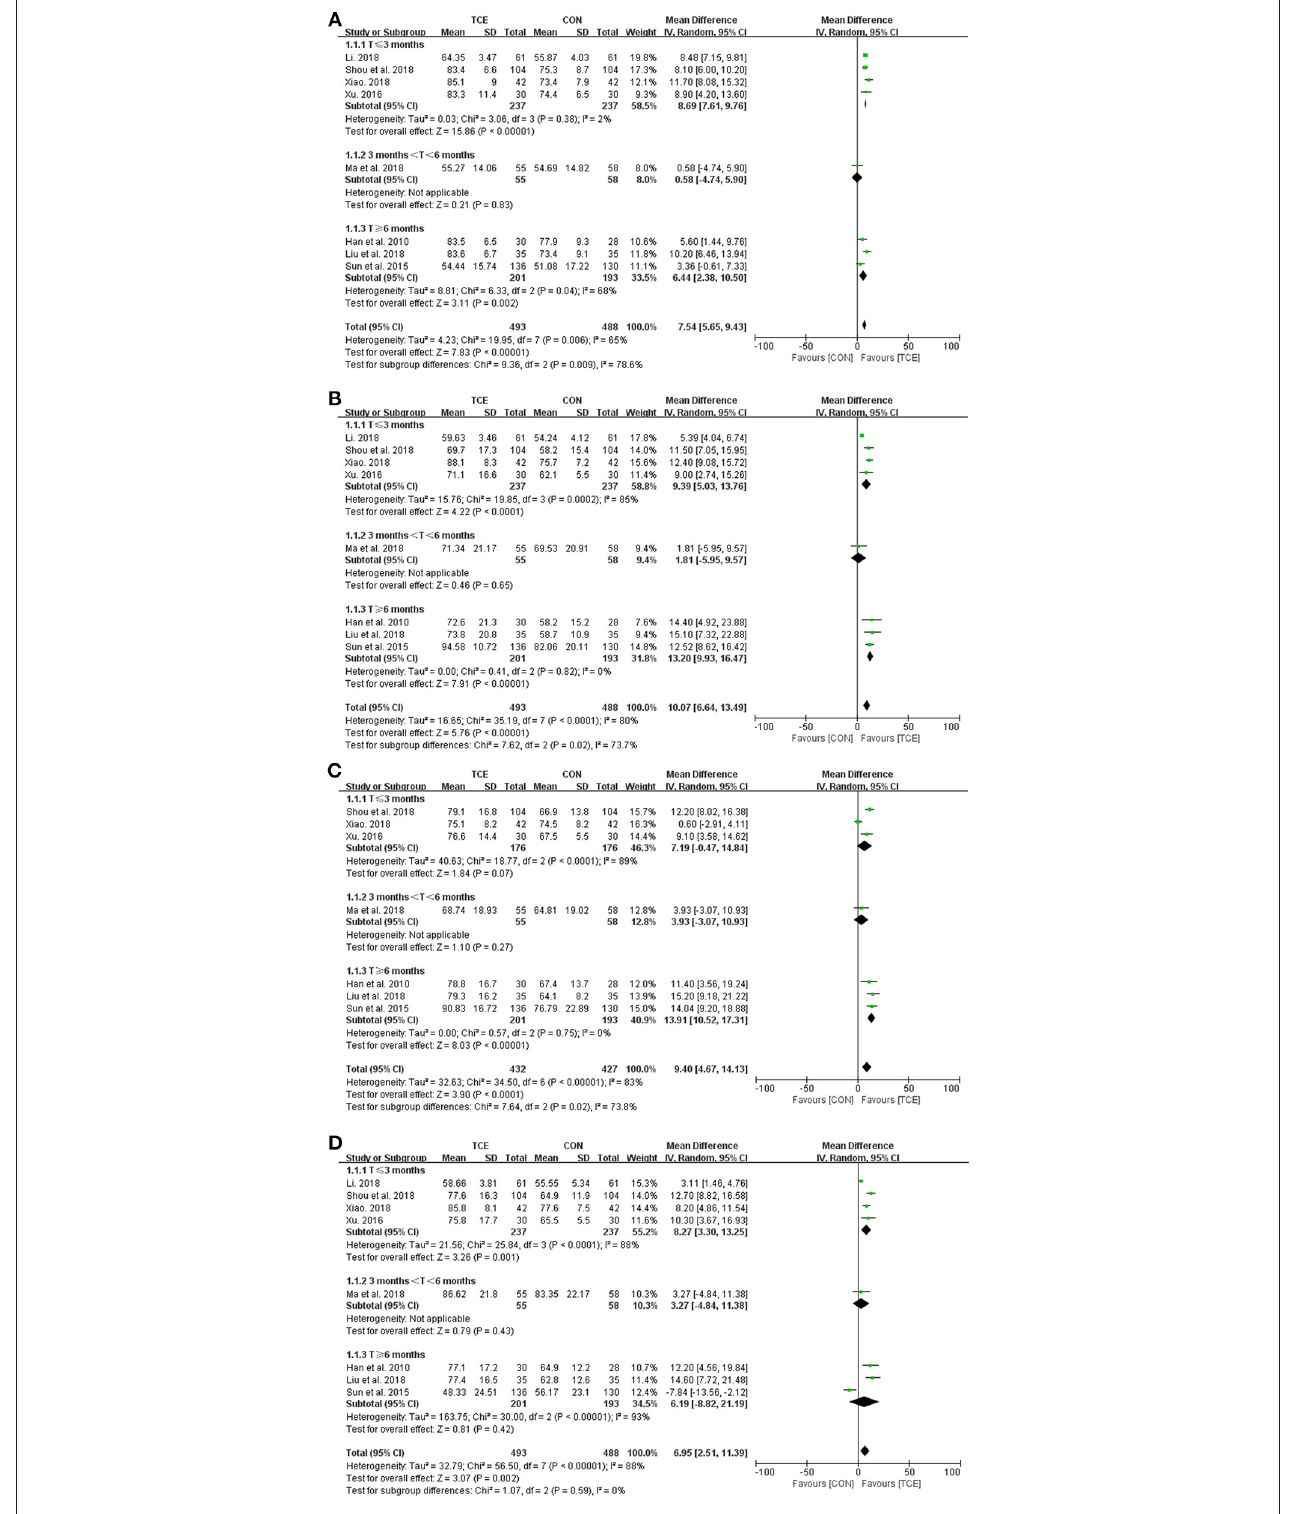
FIGURE 4 | Meta-analysis of SF-36 QOL (physical component) in the TCE group (Tai Chi) vs. the control group. (A) Physical function; (B) role physical; (C) bodily pain; and (D) general health. TCE, traditional Chinese exercises; CON, control; SD, standard deviations; CI, confidence intervals; IV, inverse variance.